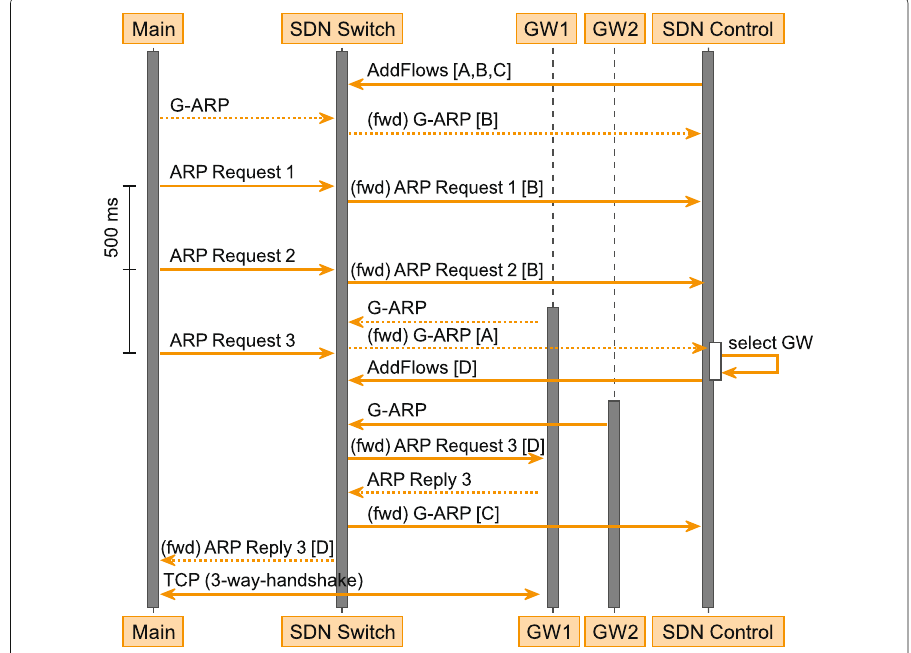
Fig. 4 The sequence diagram shows the first case using G-ARP messages for connection establishment. As intended, finally Main and GW1 establish the 104/TCP